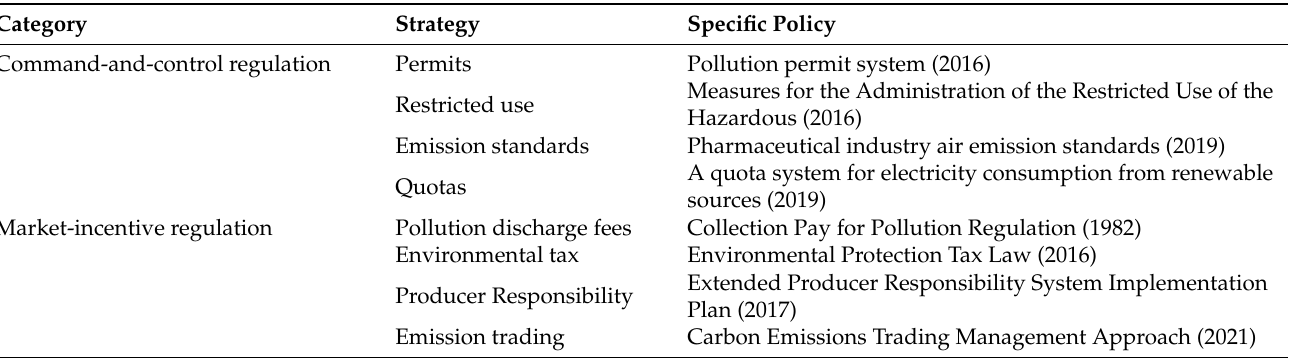
Table 1. The major environmental regulation policies in China. Category Strategy Specific